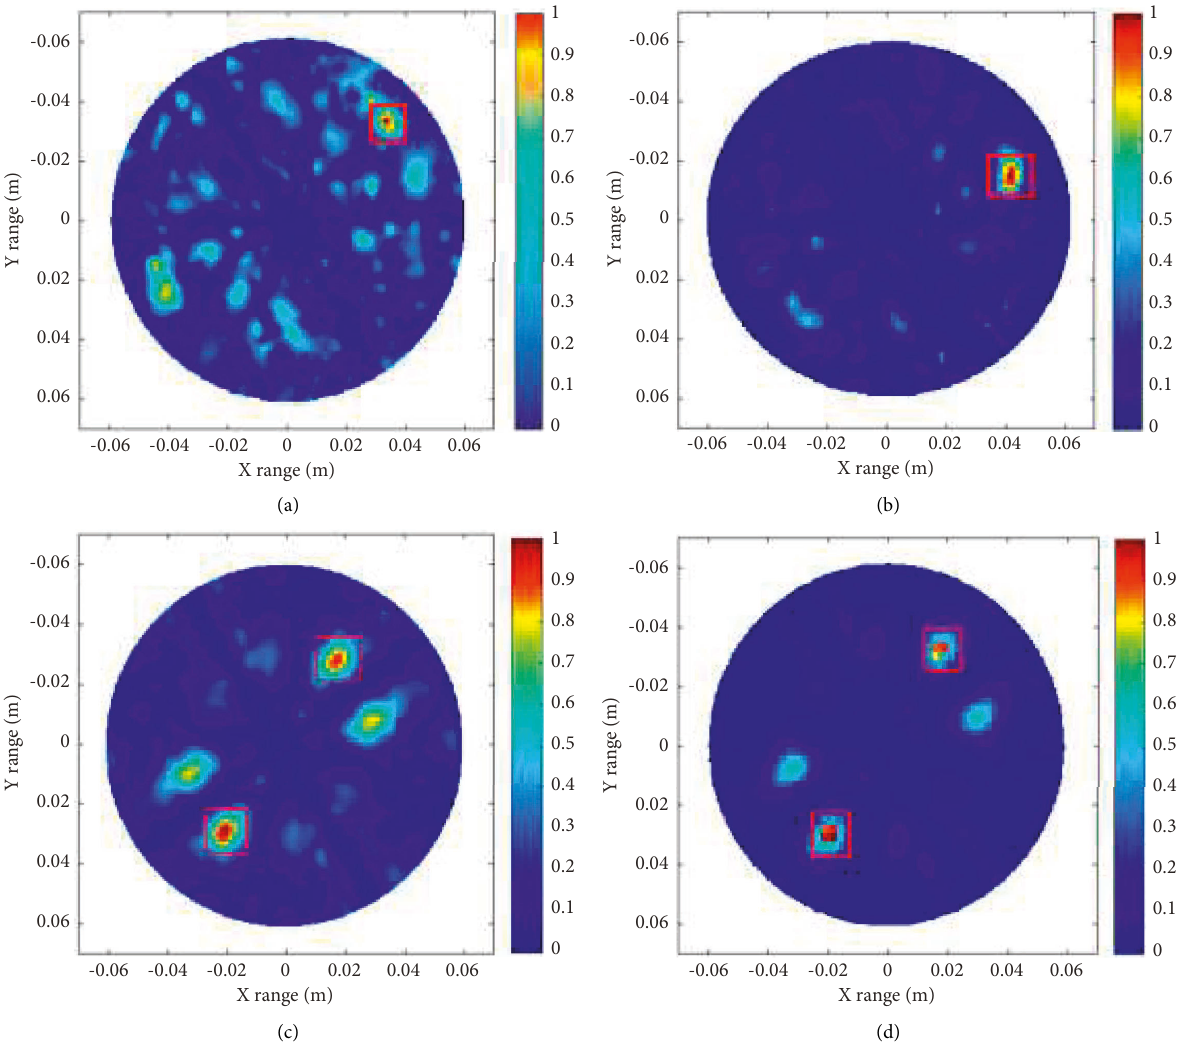
Figure 17: Reconstructed images of the tumorous breast phantom (a) single tumor (DAS), (b) single tumor (DMAS), (c) double tumor (DAS), and (d) double tumor